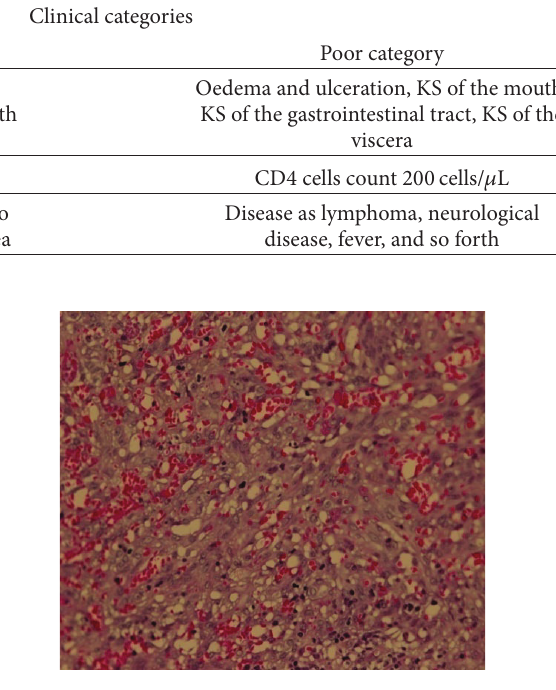
Figure 3: (H E 200x). KS of the tonsil demonstrates irregularly shaped vascular channels, interlacing bundles of spindle-shaped cells.